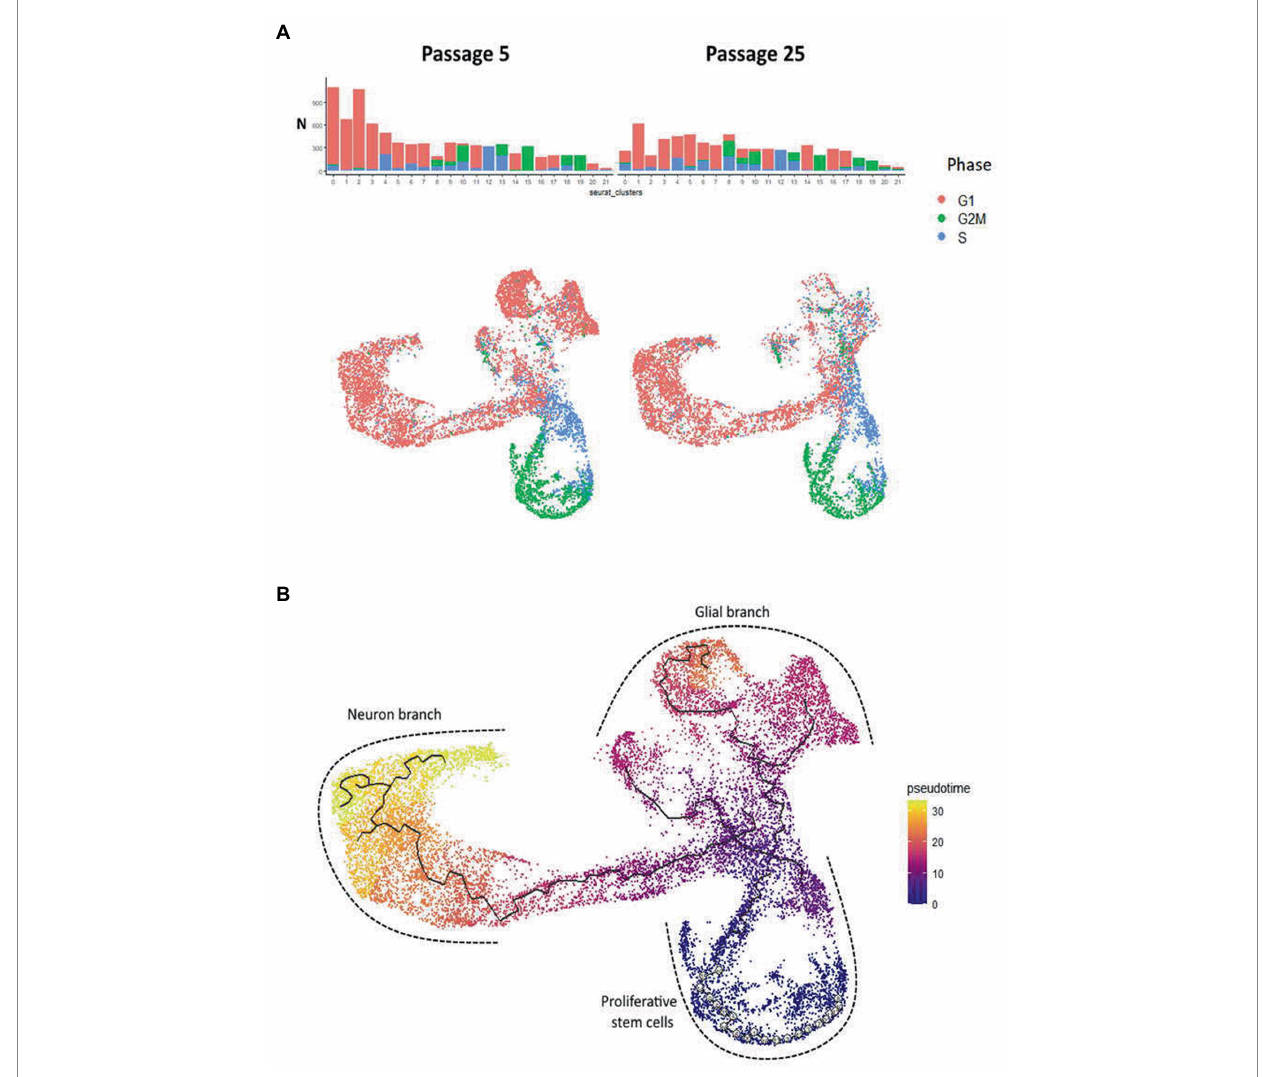
FIGURE 8 Cell cycle phases and pseudotime analysis of scRNAseq results from N-KYOU p5 and p25. (A) The occupancy and cell cycle of the detected clusters, N indicates the number of cells in the cluster. (B) Monocle trajectory analysis shows several directions of stem cell differentiation, from the area of proliferative stem cells through the glial or neuron